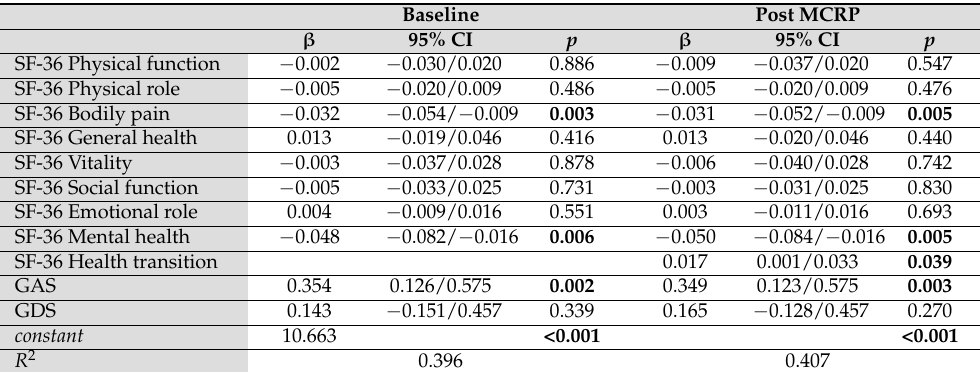
Table 4. Linear correlation of the initial and final values of the Pittsburgh Sleep Quality Index with respect to the SF-36 and Goldberg